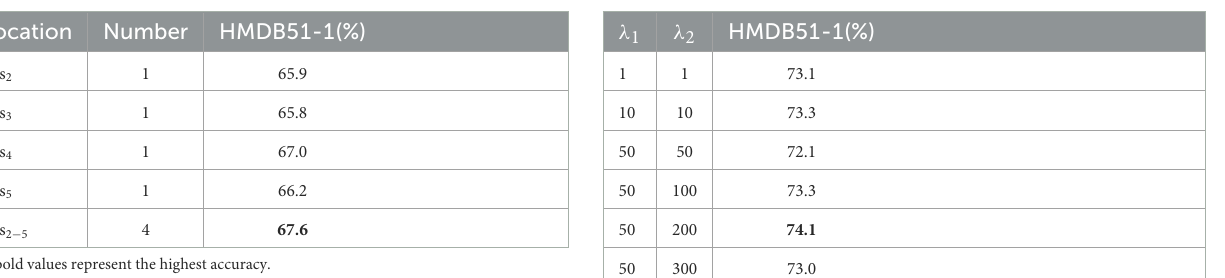
TABLE 4 The effect of λ 1 and λ 2